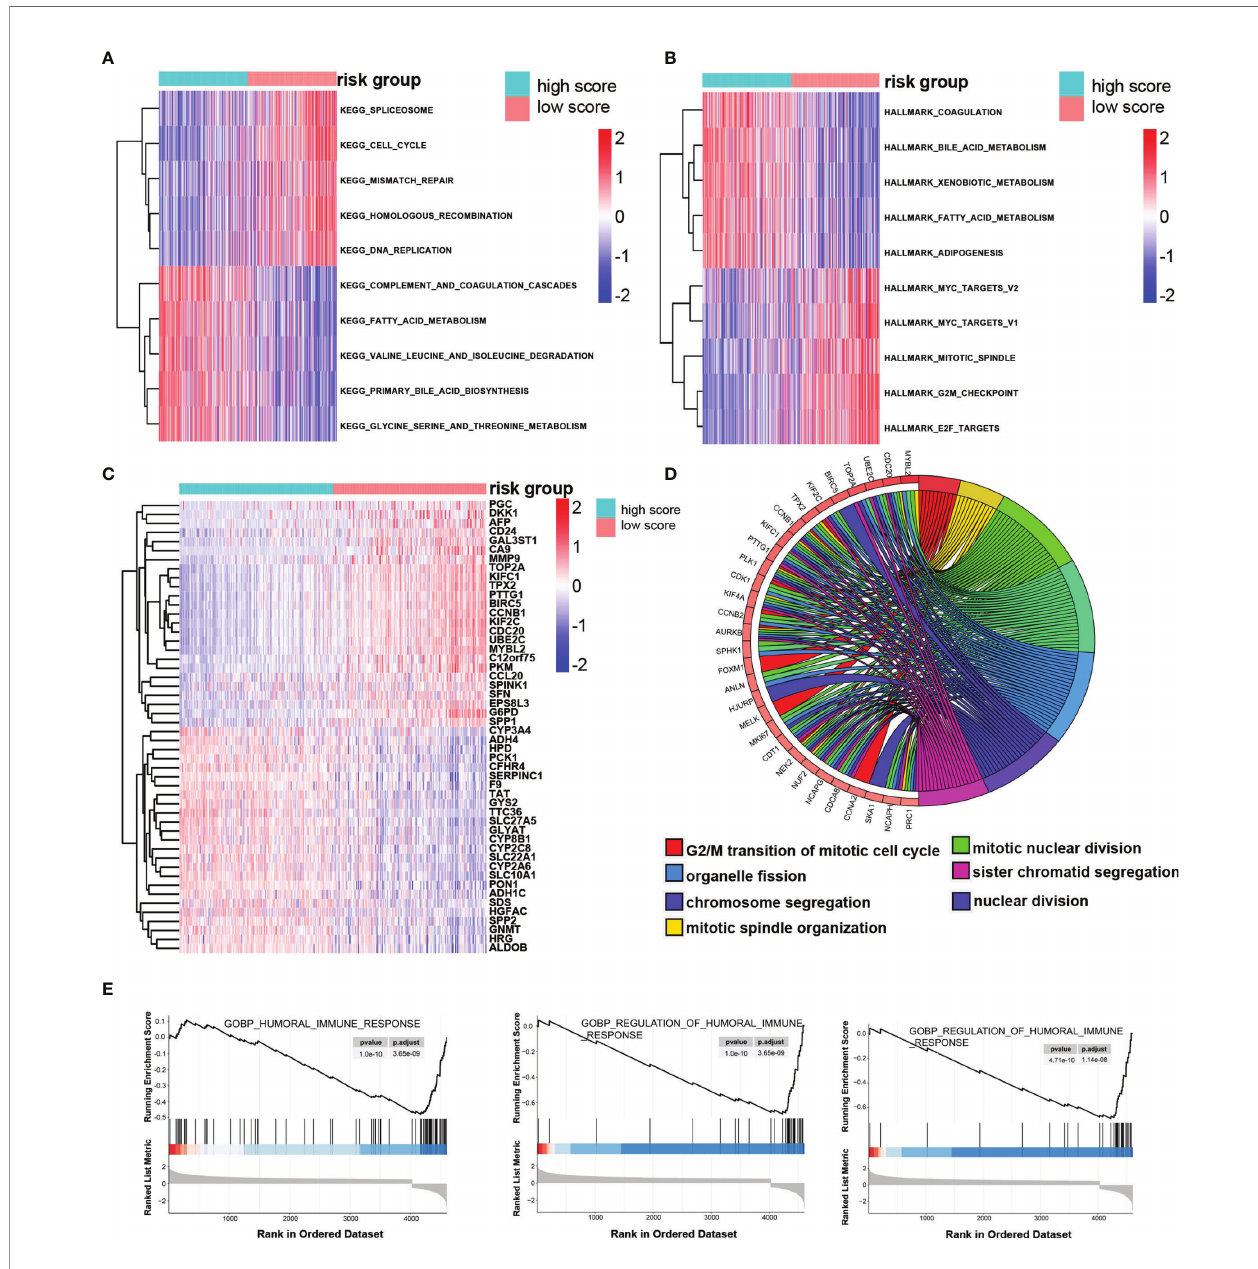
FIGURE 7 | The potential molecular mechanism of the TRP score. (A, B) GSVA-KEGG and GSVA-HALLMARK for the TRP score. (C) The heatmap of DEGs between high- and low-TRP score groups. (D) GO function annotation of DEGs. (E) GSEA using immune gene